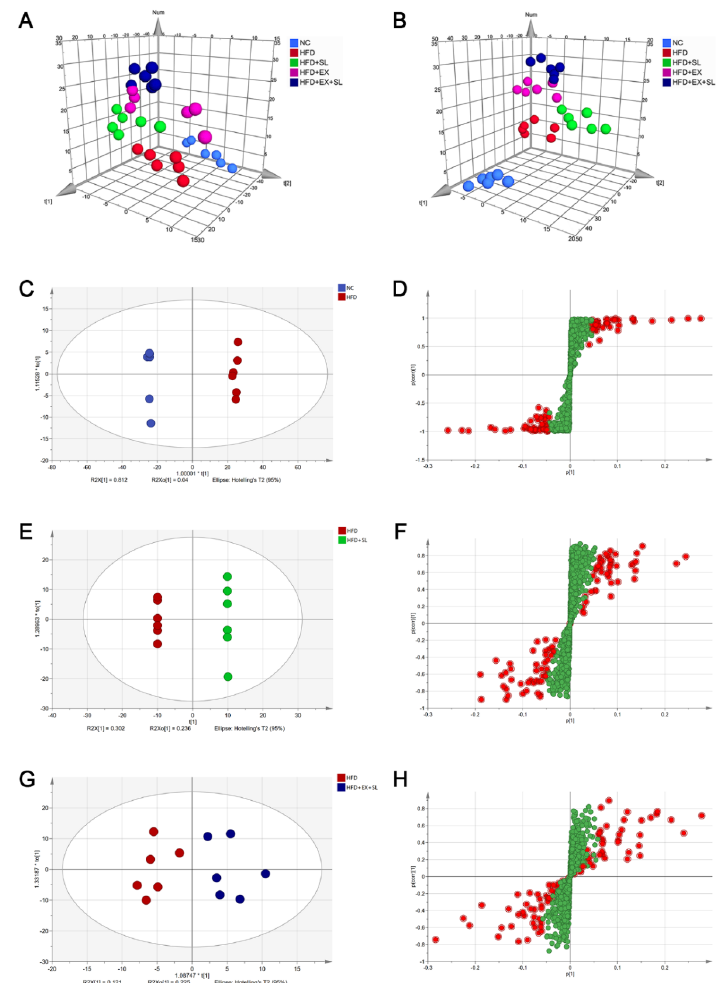
Figure 4. Score plots of the PCA, PLS-DA and OPLS-DA models of the five groups. ( A ) 3D PCA score plot of the five groups [R2X(cum) = 0.761, Q2(cum) = 0.687]. ( B ) 3D PLS-DA score plot of the five groups [R2X(cum) = 0.757, Q2(cum) = 0.357]. ( C ) OPLS-DA score plot between NC group and HFD group [R2X(cum) = 0.852, Q2(cum) = 0.995]. ( D ) S-plot between NC group and HFD group. ( E ) OPLS-DA score plot between HFD group and HFD + SL group [R2X(cum) = 0.88, Q2(cum) = 0.845]. ( F ) S-plot between HFD group and HFD + SL group. ( G ) OPLS-DA score plot between HFD group and HFD + EX + SL group [R2X(cum) = 0.347, Q2(cum) = 0.087]. ( H ) S-plot between HFD group and HFD + EX + SL group. Potential variables in S-plot are marked in red when VIP >1.5.